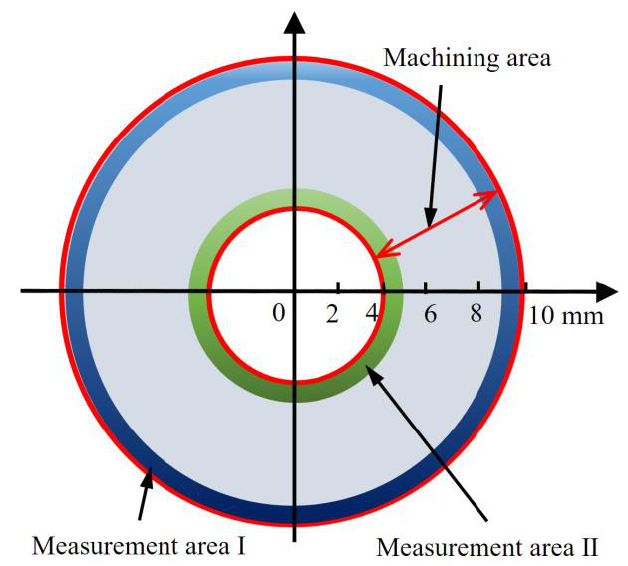
Figure 4. Schematic of machining area and measurement areas.